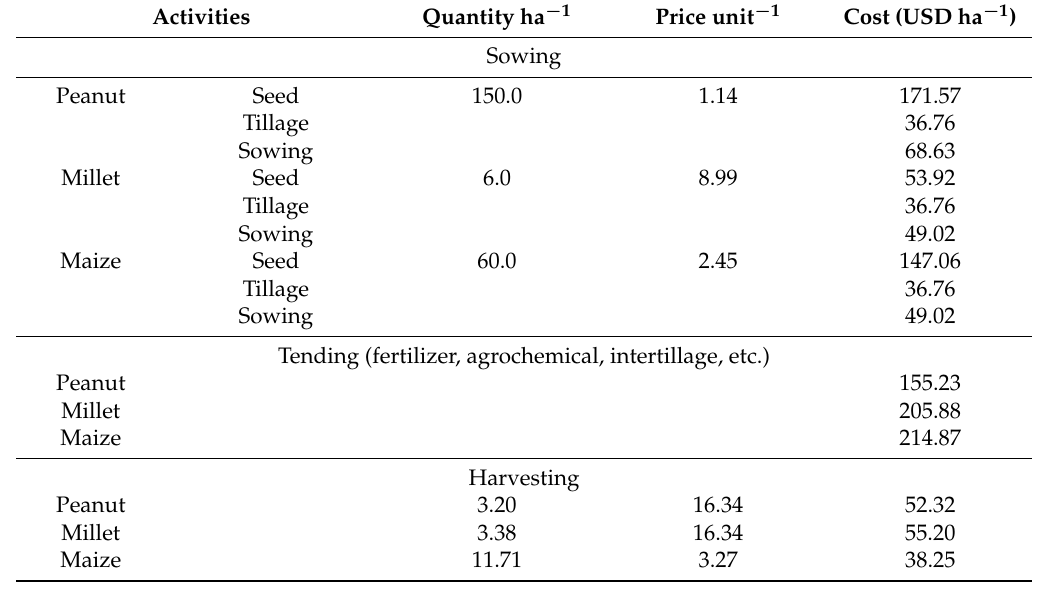
Table 5. Cost structure of crop monoculture systems in Exp.2.